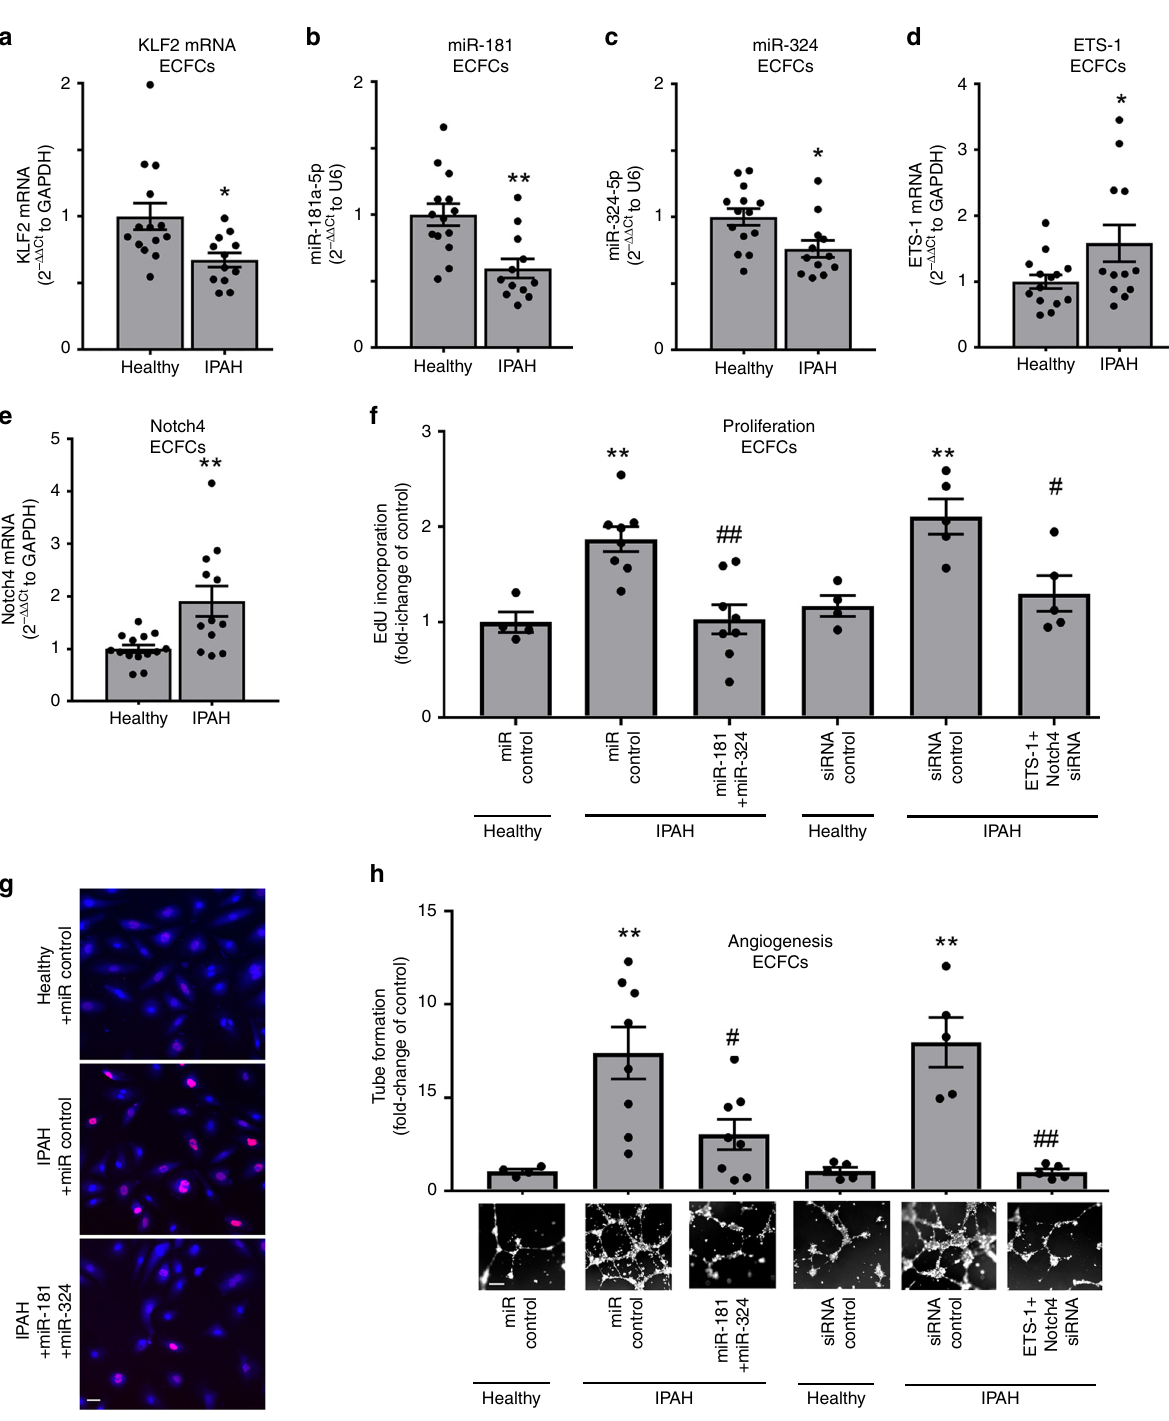
Fig. 6 Dysregulation of KLF2 signalling in ECFCs from IPAH patients. a KLF2 mRNA, b miR-181 and c miR-324, d ETS-1 and e Notch4 expression in ECFCs from healthy volunteers ( n = 14) and IPAH patients ( n = 12). f , g Proliferation (EdU incorporation) and h angiogenesis (matrigel tube formation) in ECFCs from healthy individuals and IPAH patients, transfected with control miRNA, control siRNA, miR-181 and miR-324 or Notch4 and ETS-1 siRNA, as indicated. Representative corresponding images of tube formation in fl uorescently labelled live ECFCs are shown underneath the graph. In g EdU-incorporating nuclei are pink. In g bar = 20 µ m and in h bar = 100 µ m; * P < 0.05, ** P < 0.001, comparison with corresponding controls; # P < 0.05, ## P < 0.01, comparison between controls and miR-181 and miR-324- or ETS-1 and Notch4-treated IPAH ECFCs. Bars are means ± s.e.m. In a – e n = 12 – 14, unpaired t -test and in f , h n = 4 – 8, one-way ANOVA with Tukey post-test. All n numbers are biologically independent samples. Source data are provided in Source Data fi